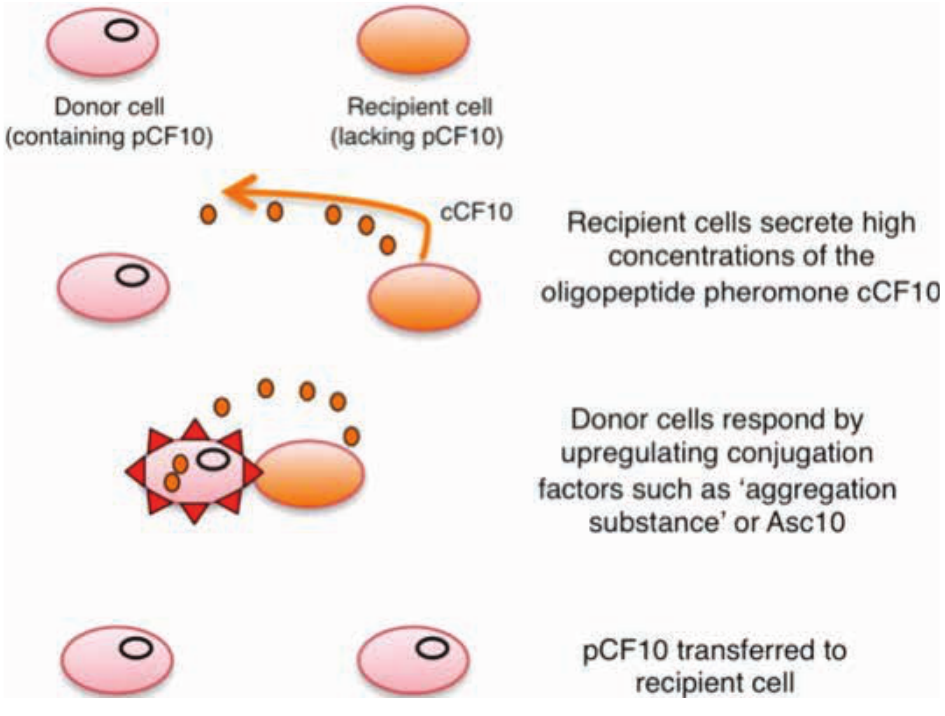
Figure 3. E. faecalis conjugation